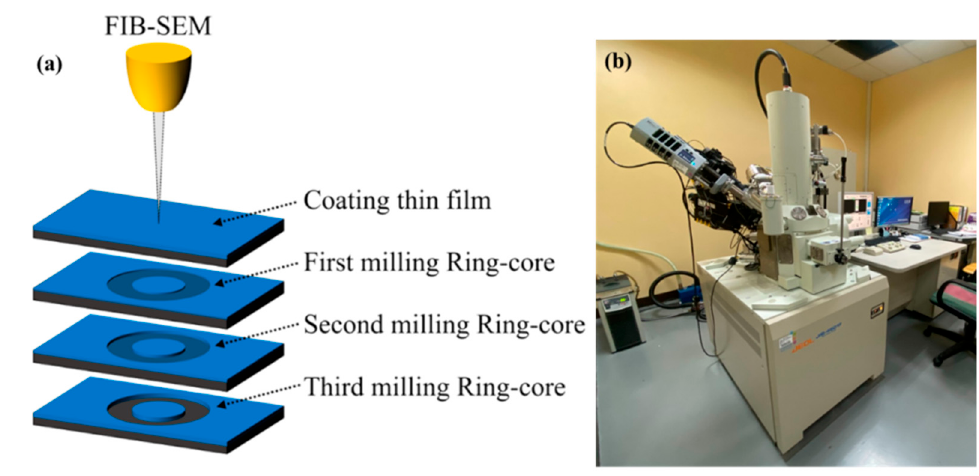
Figure 3. ( a ) Focused ion beam (FIB)-SEM process diagram. ( b ) FIB-SEM experimental system (Equipment JEOL JIB-4601F).